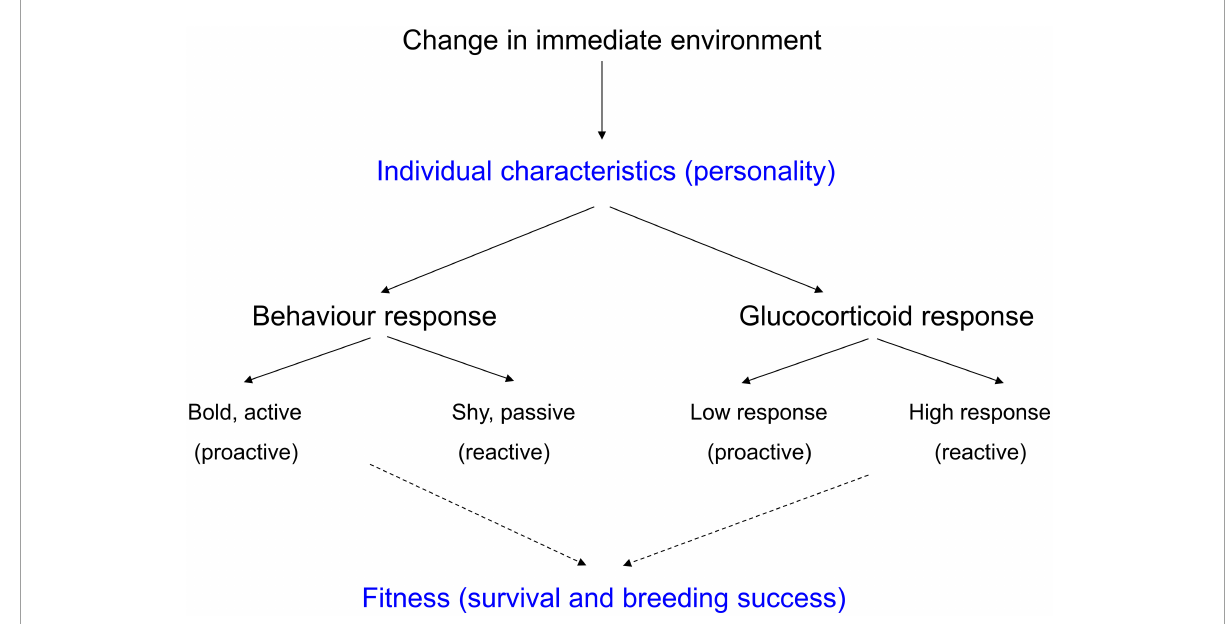
FIGURE4 The influence of individual characteristics (personality) on behaviour responses, and glucocorticoid responses to changes in the immediate environment. These responses both influence fitness [based on Cockrem (2007,